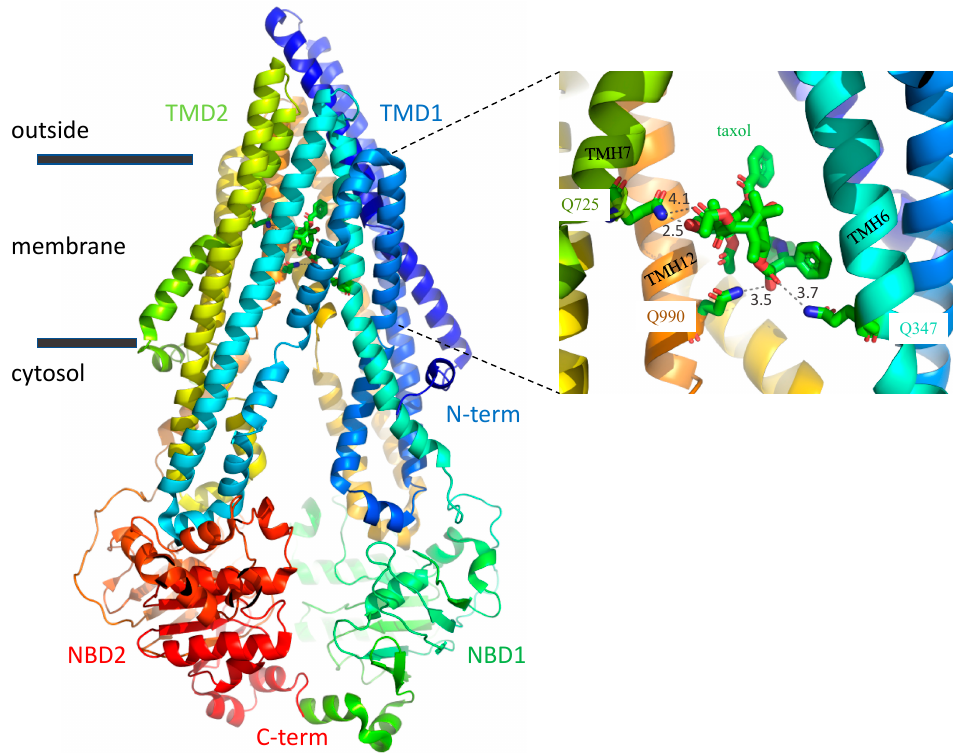
Figure 1. The taxol binding pocket. Ribbon depiction of ABCB1 with taxol occluded by the transmembrane domains (TMD1, blue-turquoise spectrum; TMD2, green-orange spectrum). The nucleotide binding domains, NBD1 and NBD2, are shown in green and red, respectively (pdb: 6QEX). The right-hand panel shows a 12Å slice in the Z plane of the taxol binding site. The three glutamines Gln 347 , Gln 725 , and Gln 990 highlighted by Alam et al. [6] to hydrogen bond (dashed grey lines) with the taxol are show in single letter code and stick format with the bond lengths (N-O) indicated in black in Ångstroms. The combination of bond angle and length suggests that Gln 725 forms the strongest and only H-bond with the baccatin III tetracyclic ring, while Gln 347 and Gln 990 form weaker H-bonds with the carbonyl and hydroxyl, respectively, which link to the diphenolic tail of the drug.